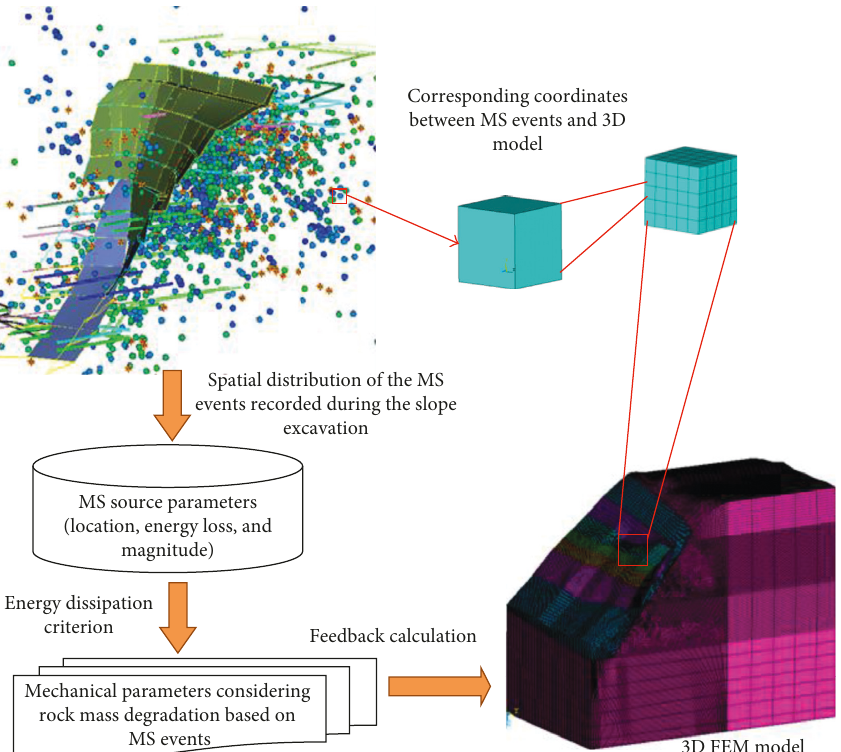
Figure 11: Flowchart of the back analysis of slope stability considering the effects of MS